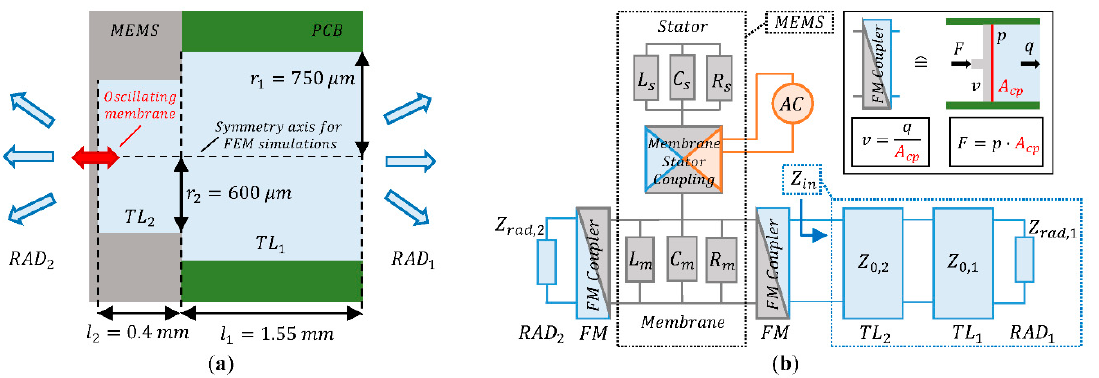
Figure 1. ( a ) Schematic view of the system with geometrical dimensions; ( b ) Equivalent circuit composed of the acoustic (blue), the mechanical (grey) and the electrical (orange) energy